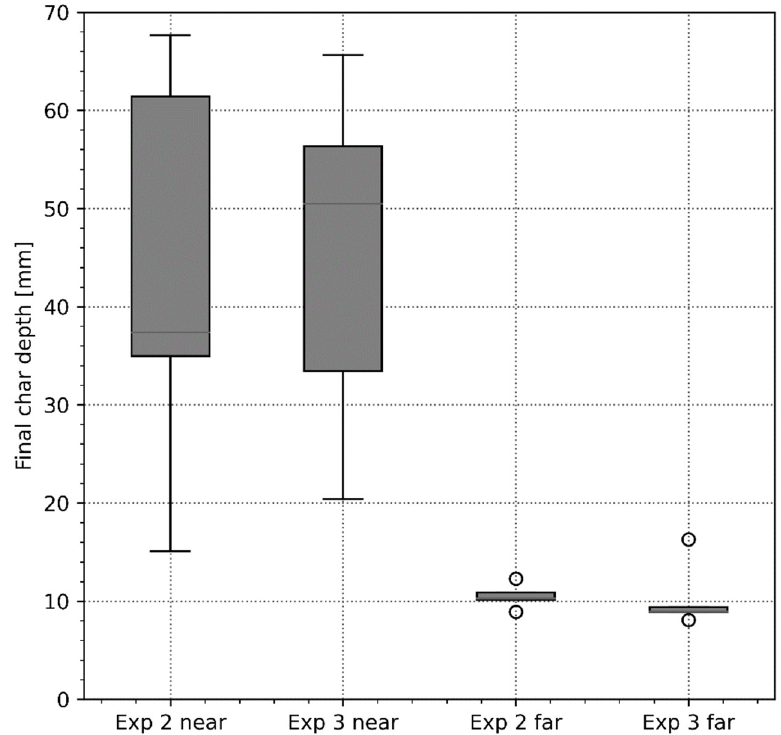
Figure 23. Box plot of final charring depth in Experiments 2 and 3 for the CLT slab above the burner (near) and away from the burner (far). Table 3. Maximum charring depths at different locations in Experiments 2 and 3, and estimated equivalent duration of furnace